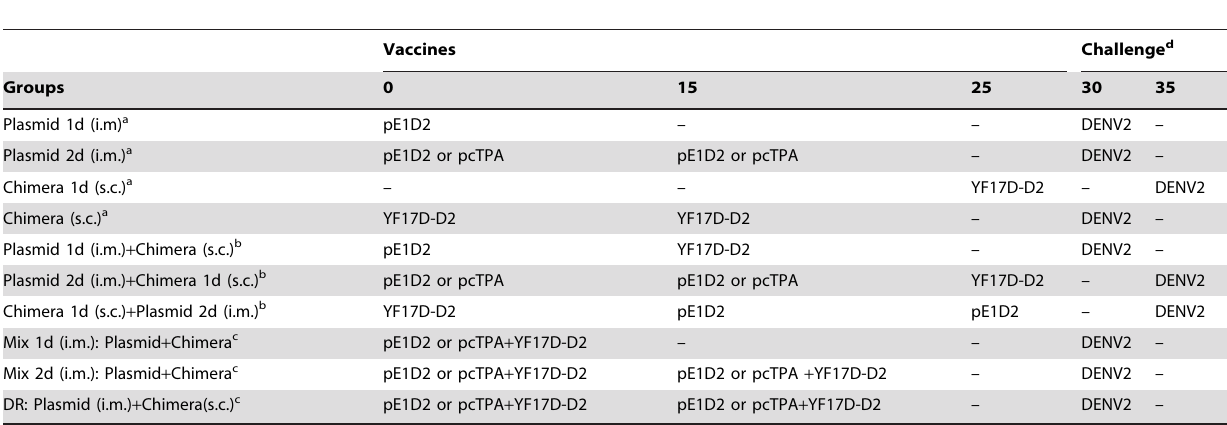
Table 1. The different immunization protocols using the pE1D2 DNA vaccine and/or YF17D-D2 chimeric